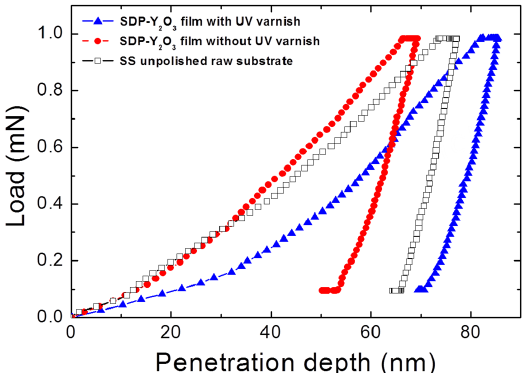
Figure 9. Nanoindentation curves for the SDP-Y 2 O 3 films with and without UV varnish (triangle solid blue line and dot solid red line, respectively) and the SS unpolished raw substrate (empty black square line). Table 4. Mechanical properties of the unpolished SS raw substrate and 100 nm thick SDP-Y 2 O 3 films deposited from inks with and without UV varnish.